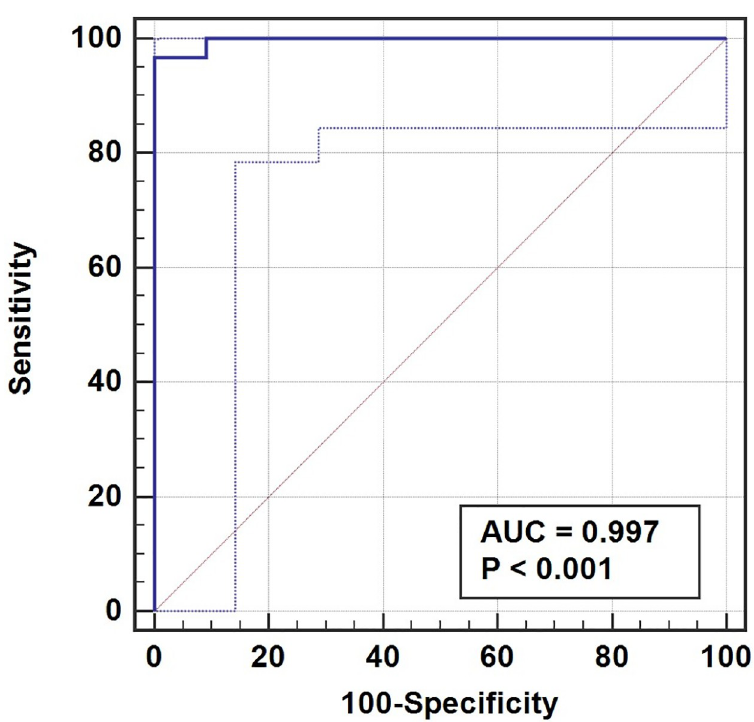
Fig 3. HSV-2 PLNP LFA receiver operating characteristic (ROC) curves. Each panel member was tested and analyzed in replicate (n = 2), by SeraCare, Inc, using HerpeSelect 2 ELISA from Focus Diagnostics, and the resulting absorbance mean was normalized to generate signal-to-cutoff ratios (reactivity ratios). Following SeraCare’s reported specifications, we considered panel members with average reactivity ratios < 1.0 and � 1.0 as negative and positive, respectively, for human IgG antibodies specific to HSV-2. The panel was tested three times using the HSV-2 PLNP LFA (n = 63) with smartphone-based imaging and app readout. TLs above or below the range of quantitation of the iPhone app were given a value of 71 (the upper limit of quantitation) or 0, respectively. An HSV-2 PLNP LFA receiver operating curve (solid dark blue curve) was generated in MedCalc (version 18.2.1) using test line signal and positive cutoff values, to determine a test positive or negative. Each positive or negative test was then defined as true positive, true negative, false positive, or false negative when referenced to the gold standard method, HerpeSelect 2 ELISA. Based on the ROC analysis, a positive cutoff value of 8 for the TL of HSV-2 PLNP LFA produced the highest sensitivity (96.7%) while maintaining 100% specificity. The ROC curve and analysis gave a value of 0.997 for the area under the curve (AUC) with a 95% confidence interval of 0.937 and 1.00. The confidence region for the ROC curve is represented by the area between the light blue dotted